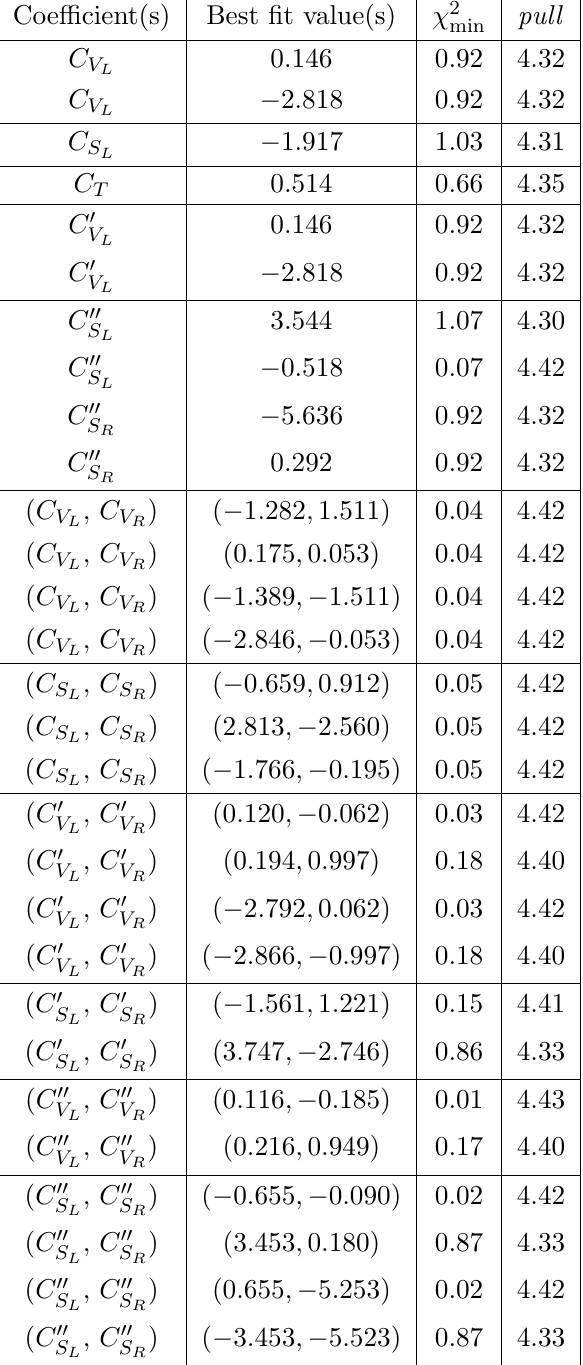
Table 2. Best (cid:12)t values of the WCs of NP operators at (cid:3) = 1 TeV for the measurements of R D , R D (cid:3) and P (cid:28) . Here we list solutions with (cid:31) 2 values are calculated using pull =